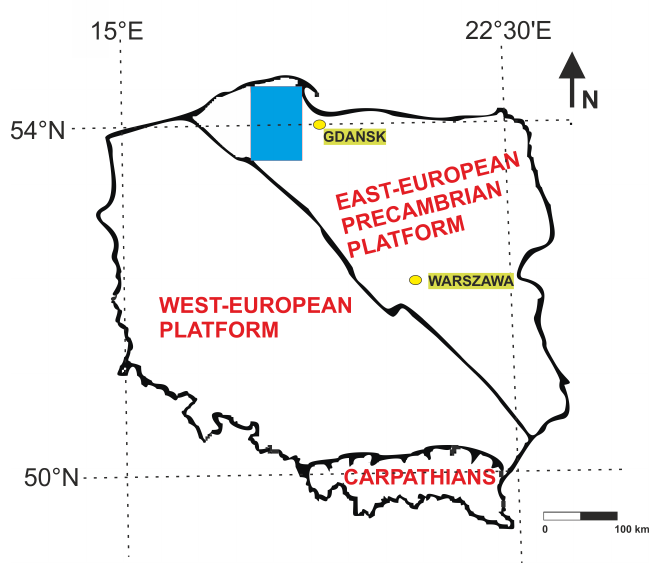
Figure 1. Location of the study area (blue rectangle) in relation to Poland’s general tectonic units (see in [9]